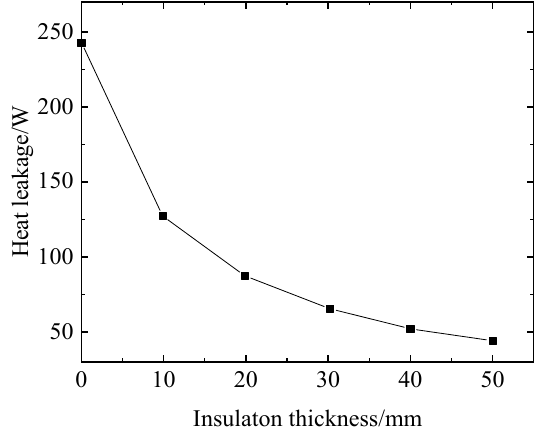
Figure 6. Curve of unit heat exchange with insulation layer thickness.